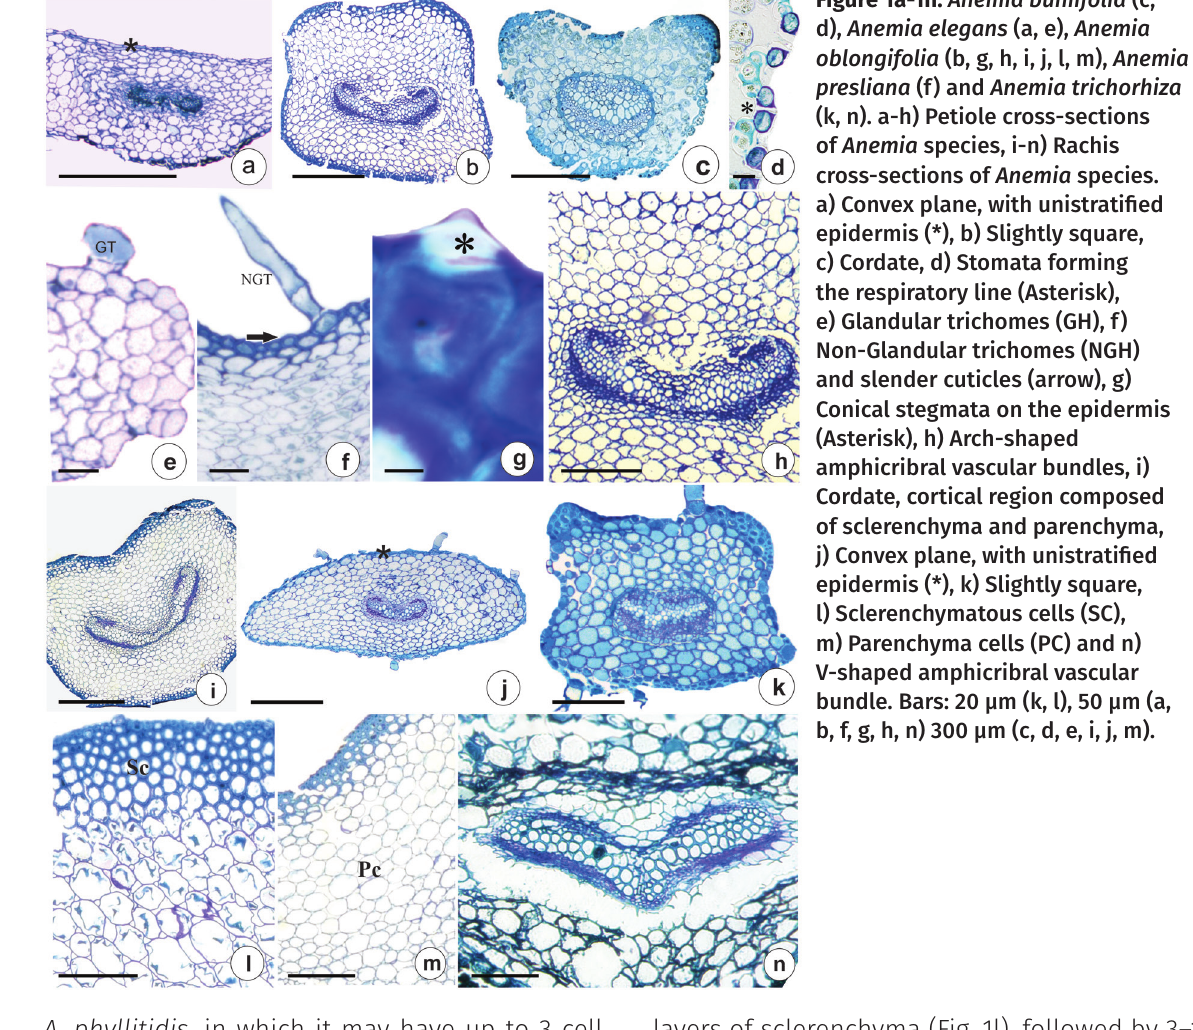
Figure 1a-1n. Anemia buniifolia (c, d), Anemia elegans (a, e), Anemia oblongifolia (b, g, h, i, j, l, m), Anemia presliana (f) and Anemia trichorhiza (k, n). a-h) Petiole cross-sections of Anemia species, i-n)